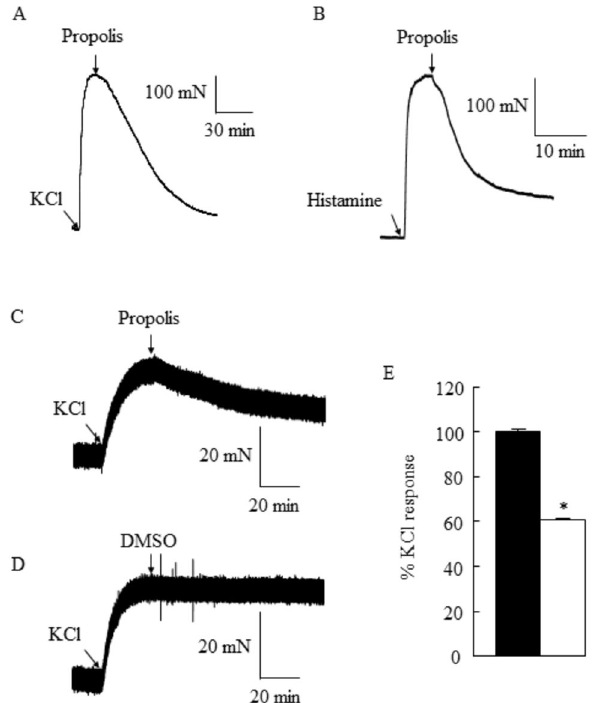
Figure 1. Original traces showing the effect of Australian stingless bee T. carbonaria propolis on vascular tone in isolated blood vessel preparations. Propolis relaxed porcine coronary arteries that were pre-contracted with 60 mM KCl (A), or 2 mM histamine (B). Propolis relaxed human umbilical arteries that were pre-contracted with 60 mM KCl (C, E; open bar), while